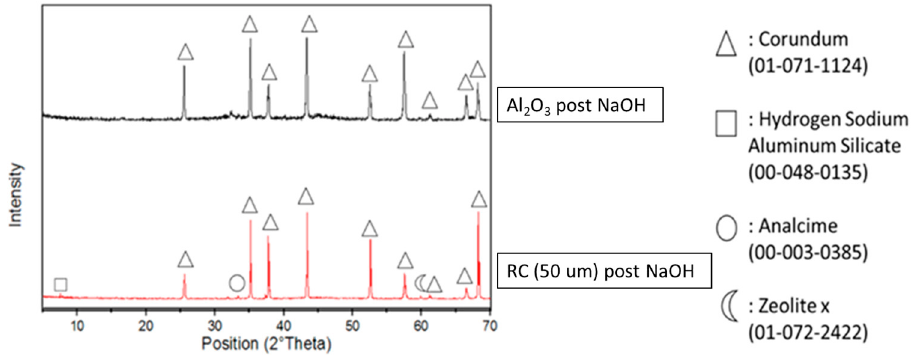
Figure 1. XRD patterns for alumina and RC, post-attack with 8 M NaOH.